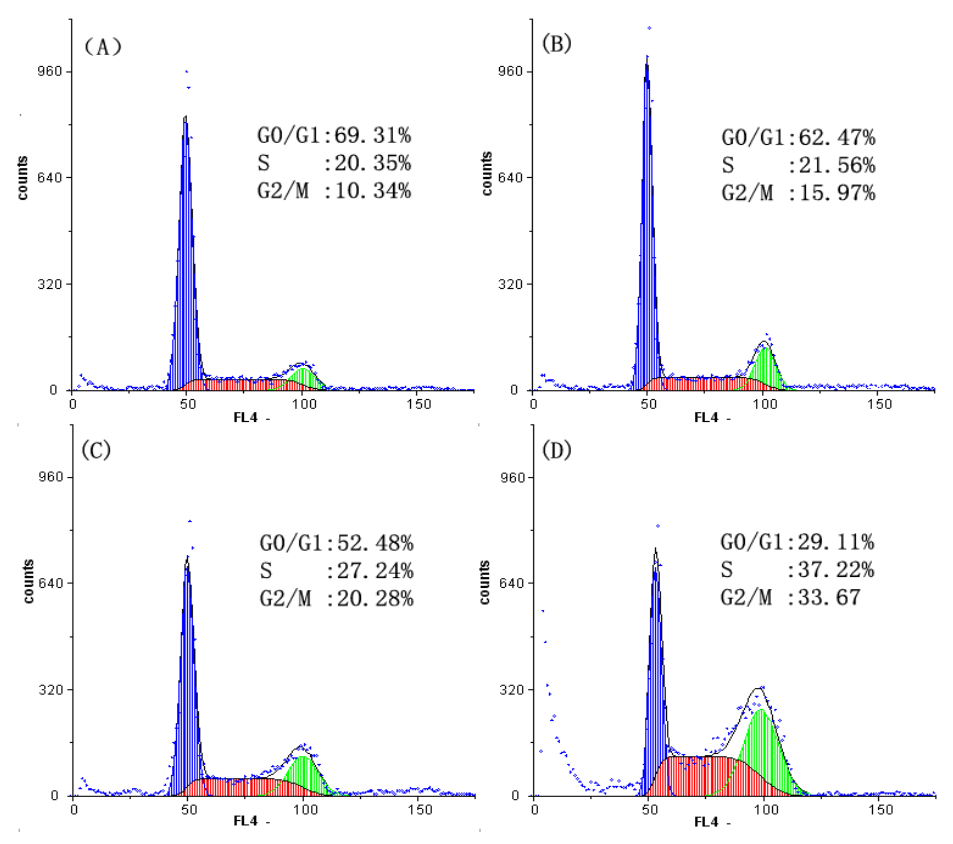
Figure 2. Effect of SFE-CO extract on the cycle of SMMC-7721 cells assayed by flow 2 cytometry analysis of DNA content. ( A ) Untreated control cells; ( B )-( D ) treatment with 50, 100 and 150 μ g/mL SFE-CO 2